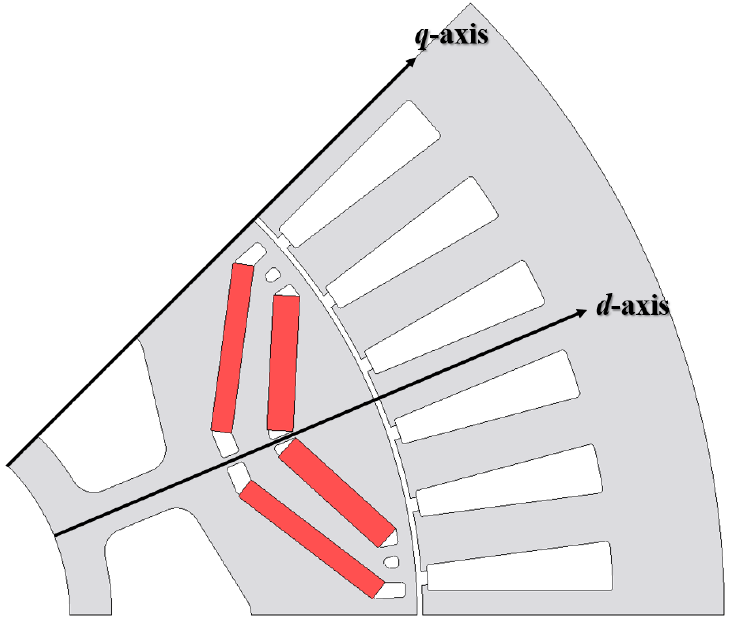
Figure 16. Modified model with a 2-layered permanent-magnet